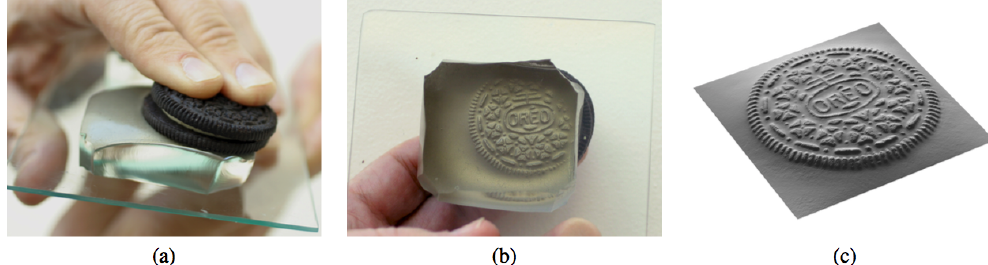
Figure 1. ( a ) a cookie is pressed against the skin of an elastomer block; ( b ) the skin is distorted, as shown in this view from beneath; ( c ) the cookie’s shape can be measured using photometric stereo and rendered at a novel viewpoint [7] (Got copyright permission from